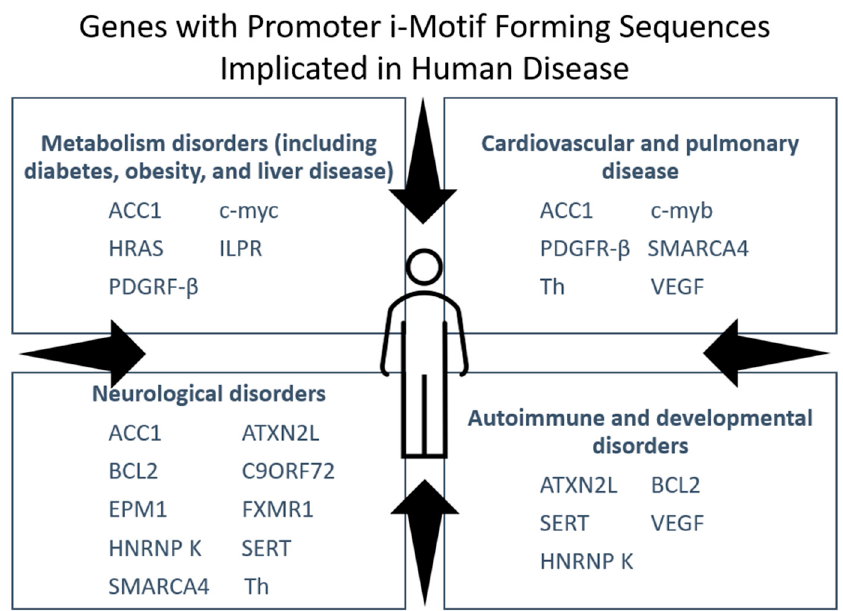
Figure 5. i-Motif sequences are found in the promoters of genes implicated in many human dis- eases besides